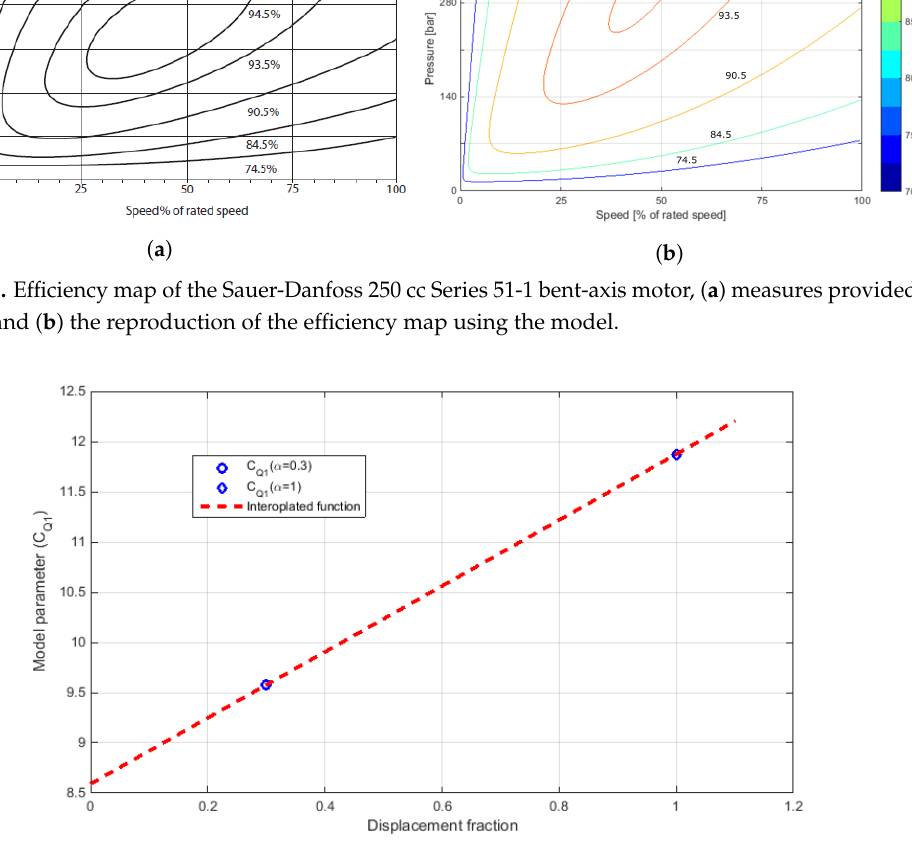
Figure 7. Fitted parameter ( C Q 1 ) for the two displacement fractions available in [38] and the linear curve that fits the two